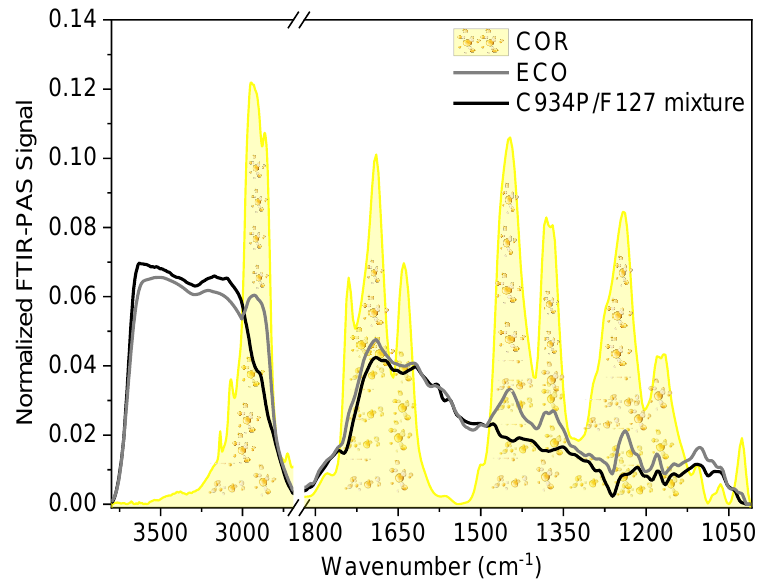
Figure 1. Normalized FTIR-PAS signal of the COR, ECO, and C934P/F127 mixture (without COR), acquired at 25 °C.